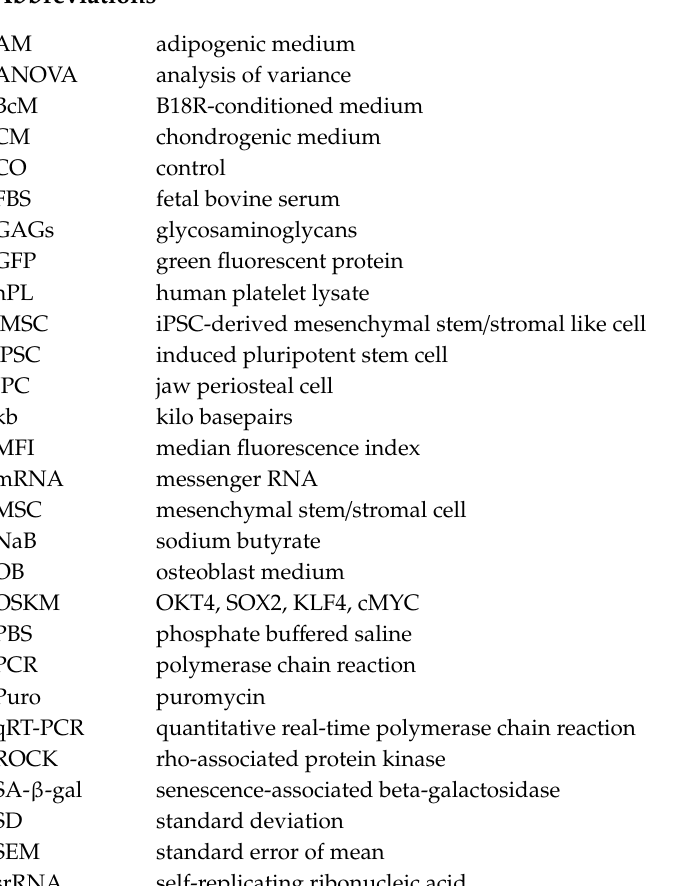
Figure S1: HLA-I and HLA-II expression of JPCs and